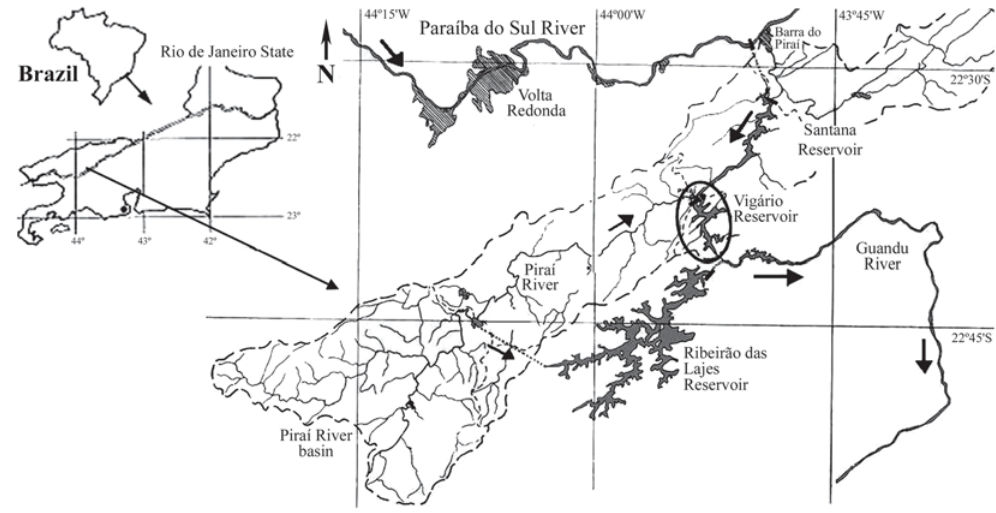
Fig. 1. Map of Vigário reservoir, showing its drainage basin (Piraí river, Paraíba do Sul river and Santana reservoir). Black arrows indicate the water flow. (Source: Gomes et al .,